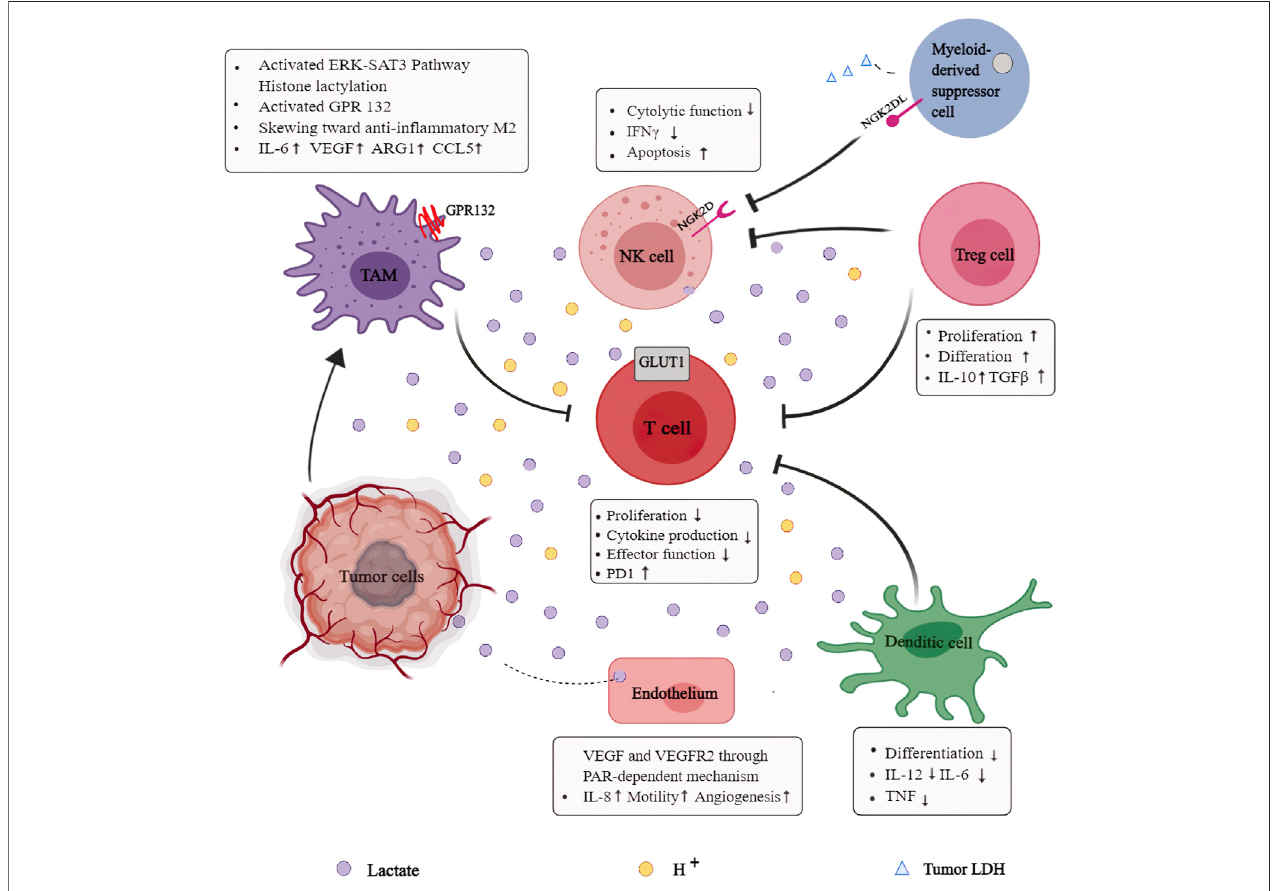
FIGURE 4 | Role of lactate in the reprogrammed immunosuppressive tumor microenvironment (TME): Extracellular lactate concentrations can be perceived and endocytotic by multiple cell types, including dendritic cells, T cells, macrophages, and NK cells, to trigger intracellular signaling, modulate cell behavior, and strongly in fl uencetheirfunctionintheTME.Lactateprovidesimmuno-metaboliccoupling betweentumor cellsand otherstromalcells,contributingtobluntimmune-surveillance.